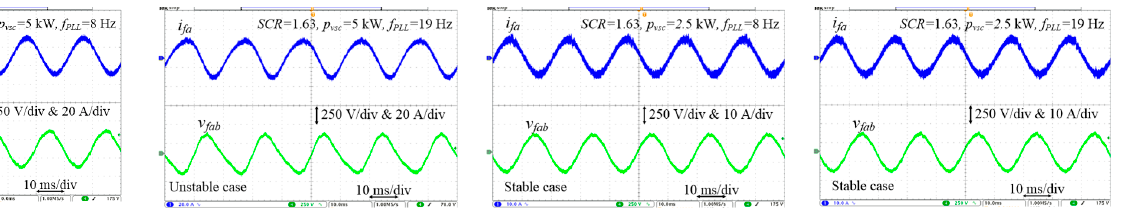
Figure 13. Experimental results showing the system response under weak grid conditions (SCR = 1.63) and different power levels ( P = 5 kW, 2.5 kW) and PLL bandwidths ( f PLL = 8 Hz, 19 Hz).